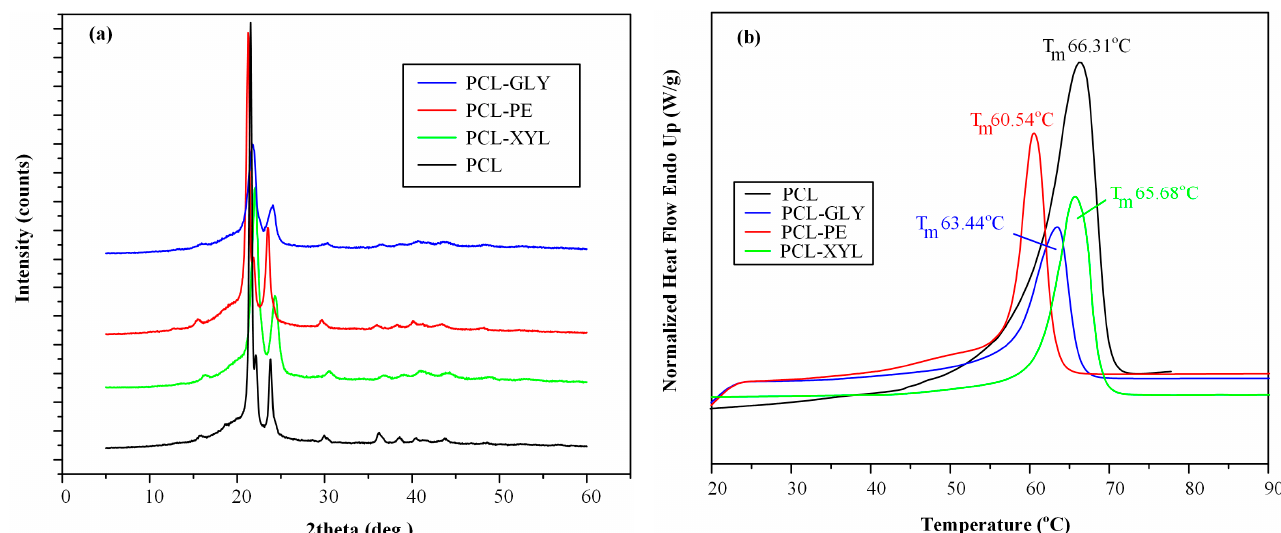
Figure 4. pXRD diffractograms ( a ) and DSC thermograms ( b ) and the three prepared branched PCL-